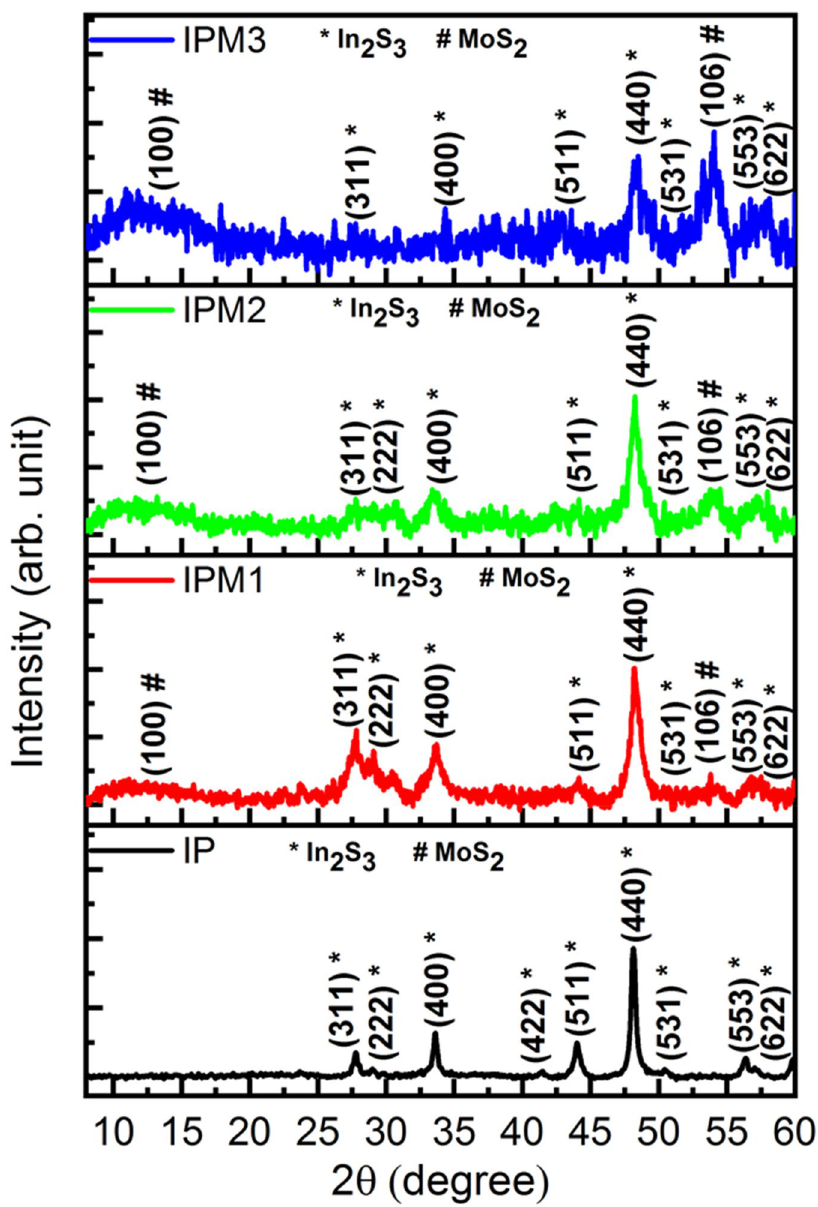
Figure 2. X-ray diffraction reflections of In 2 S 3 nanosheets and In 2 S 3 –MoS 2